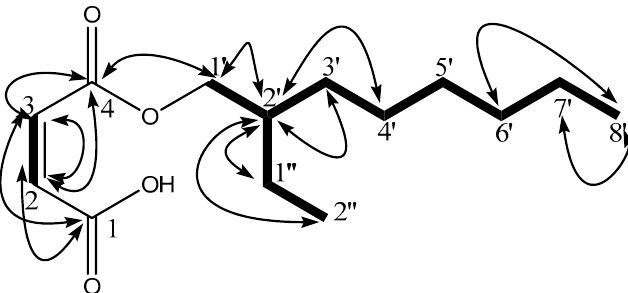
8 of 19 ) and Figure 1. Structure of compound F9 (2-ethyloctyl fumarate) with important 1 H- 1 H COSY ( ) and